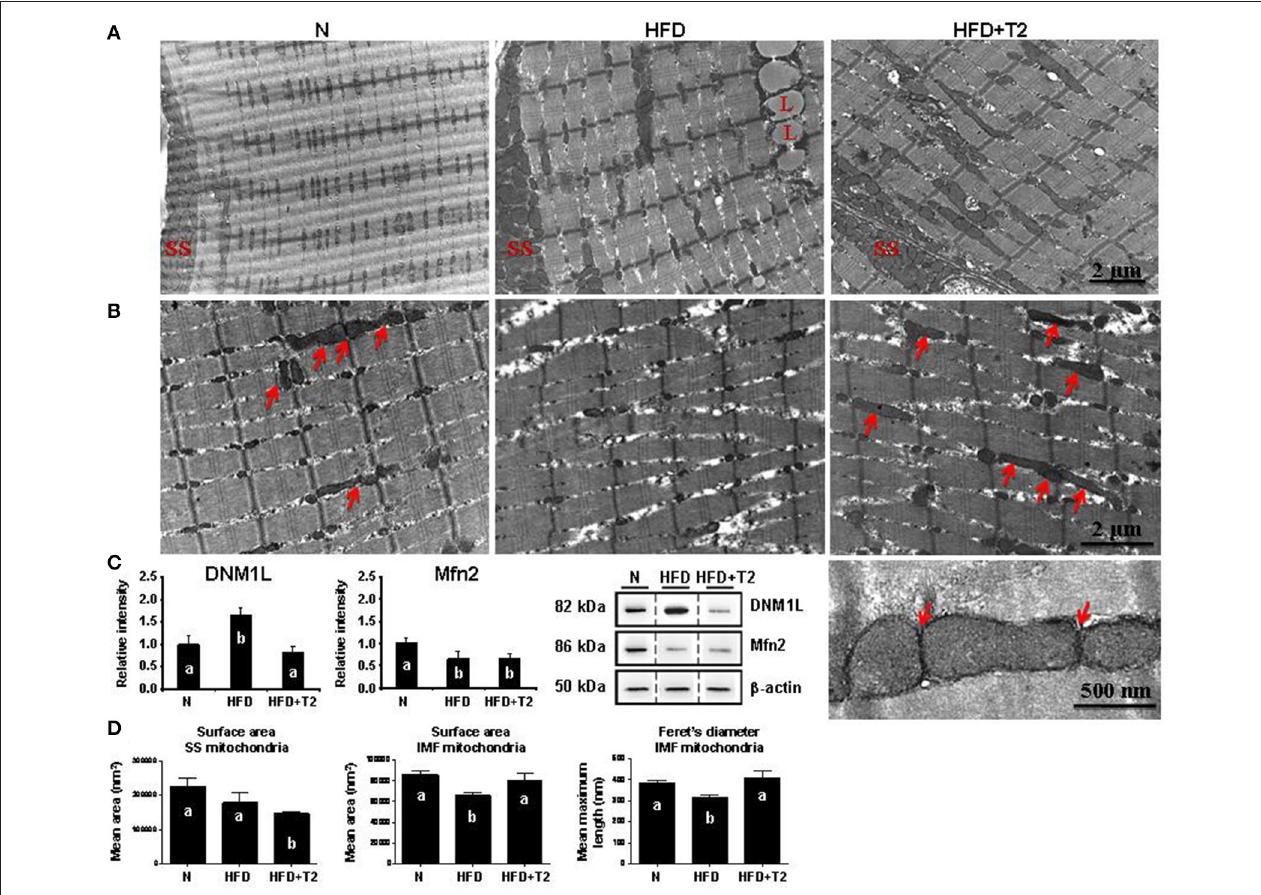
FIGURE 6 | Effects of HFD and T2-treatment on mitochondrial morphology and dynamic markers in gastrocnemius muscle of N, HFD, and HFD + T2 rats. (A) Peripheral and (B) central intermyofibrillar (IMF) regions of gastrocnemius muscle fibers in N, HFD, HFD + T2 rats. Longitudinal views in electron microscopy revealed the arrangement of subsarcolemmal (SS) and IMF mitochondria. Many continuous, elongated mitochondria were observed in N and HFD + T2 conditions (arrows). Lipid vacuoles are visible in muscle fibers of HFD animals (L). Higher magnification (bottom right image) demonstrated tubular and continuous mitochondria spanning the Z-lines as well as and electron-dense contact sites at the outer membranes of adjacent mitochondria (arrows) in gastrocemius muscle fibers of HFD + T2 rats. (C) Western blot analysis of DNM-1L and Mfn 2 protein levels in gastrocnemius muscles of N, HFD, and HFD + T2 rats. Data were normalized to the value obtained for N animals, set as 1, and presented separately for each treatment (means ± SD; n = 4/6). Bars labeled with dissimilar letters are significantly different ( P < 0.05). The vertical dotted lines indicate cuts in the membranes. (D) Mean surface area and Feret’s diameter for SS and IMF mitochondria in gastrocnemius muscle of N, HFD, and HFD + T2 rats ( n = 3). Bars labeled with dissimilar letters are significantly different ( P <